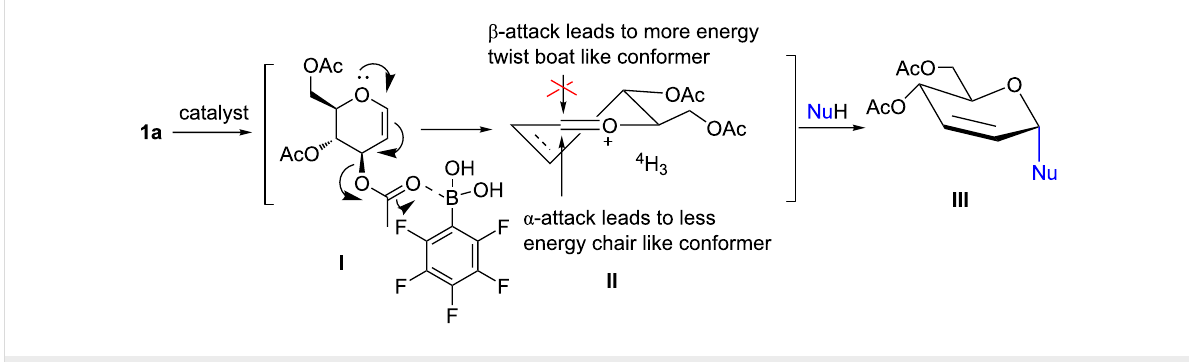
Figure 4: Plausible perfluorophenylboronic acid-catalyzed activation of glycal 1a .